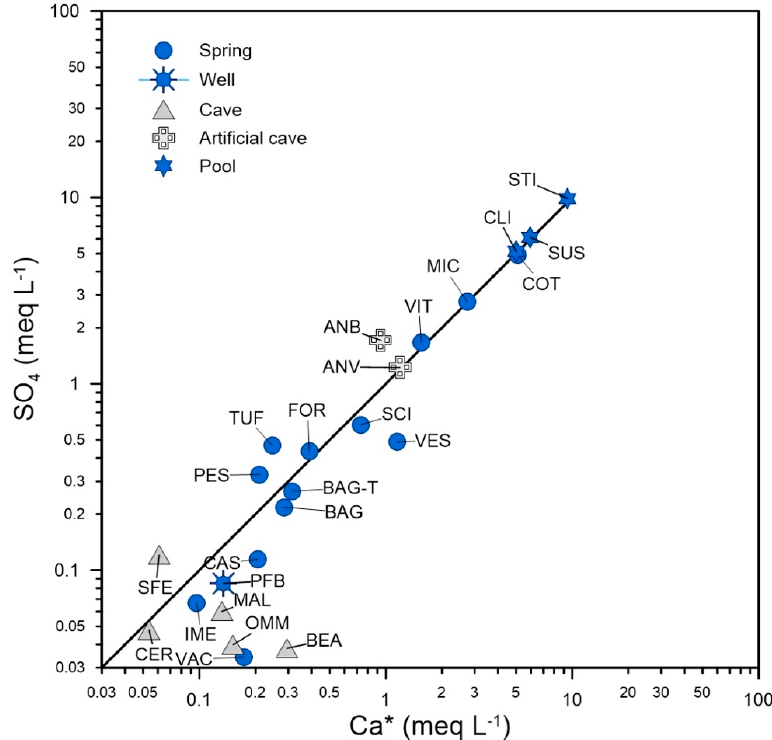
Figure 4. Binary diagram SO 4 vs Ca* (Ca-Mg-HCO 3 ), reporting the line with unitary slope, representative of the stoichiometric dissolution ratio of gypsum/anhydrite.